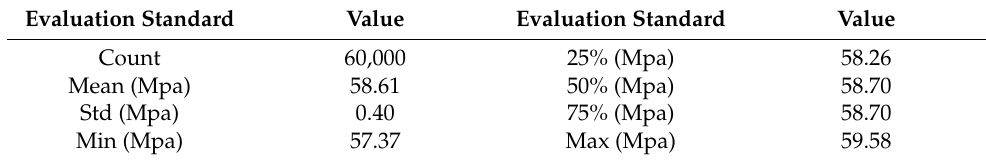
Table 1. Data description of BHP.